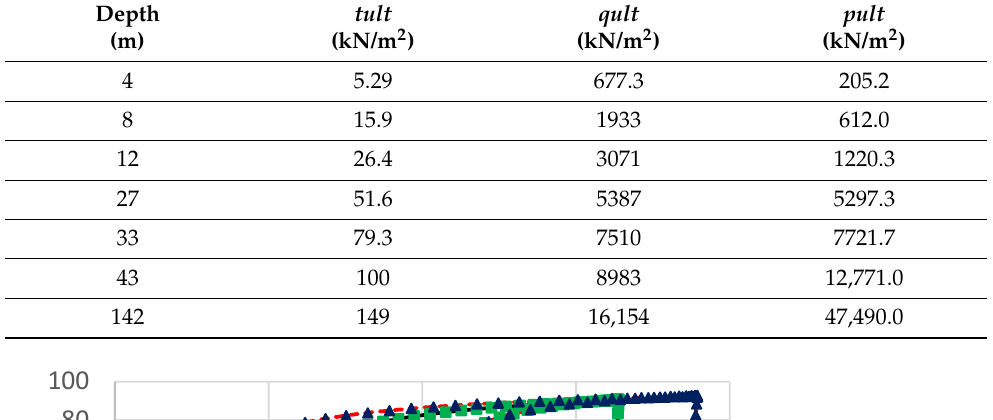
Table 1. Soil ultimate stresses of each soil layer ( tult = the ultimate shear stress for the t-z curve, qult = the ultimate tip resistance for the Q-z curve, and pult = the ultimate earth resistance for the p-y curve.).